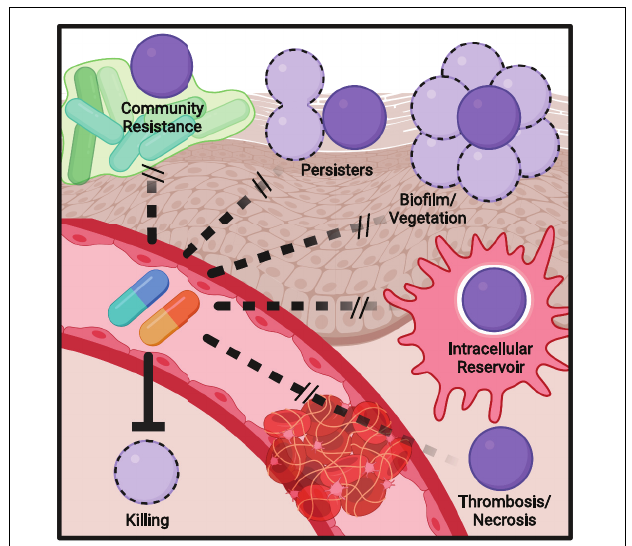
FIGURE 2 | Model of mechanisms contributing to antibiotic failure during Group A Streptococcus (GAS) infections. Community-mediated resistance mediated by protection by endogenous microbiota is likely most prevalent during pharyngitis and not invasive infections, where GAS most often exists as a monoculture. Persisters, resistant through altered growth rates or other epigenetic states, can contribute to treatment failure of any infection. The formation of biofilms, invasion of epithelial cells, and survival within phagocytes can similarly occur during any infection and serve to shield single bacterium from antibiotic action. During invasive infections in particular, inflammation- and toxin-mediated necrosis of tissue and thrombosis of dermal vasculature can limit antibiotic perfusion, necessitating surgical removal of the infected